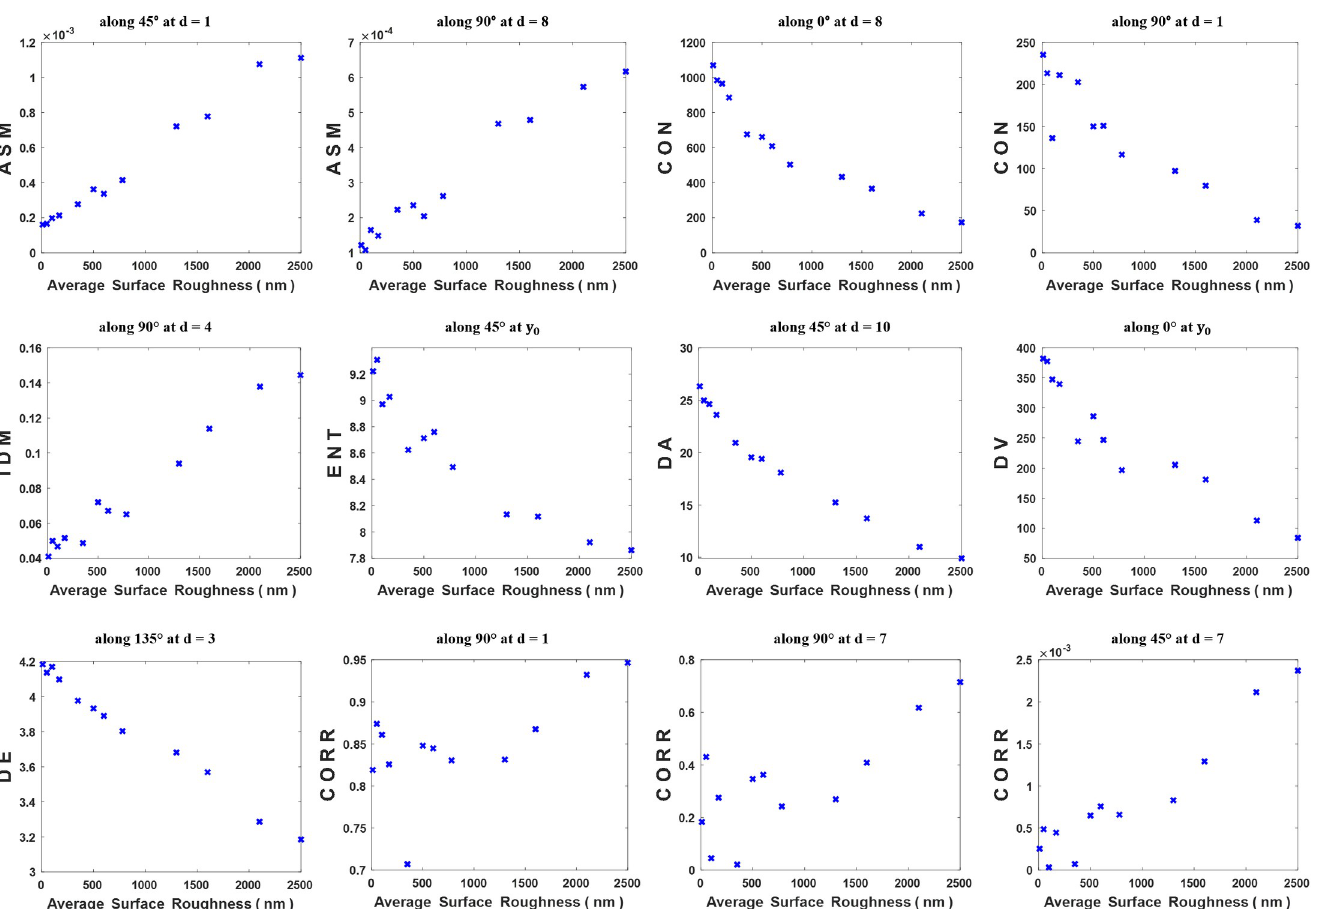
Fig 8. Computed Haralick’s statistical parameters versus the average surface roughness of the twelve articular cartilage cross-section areas.